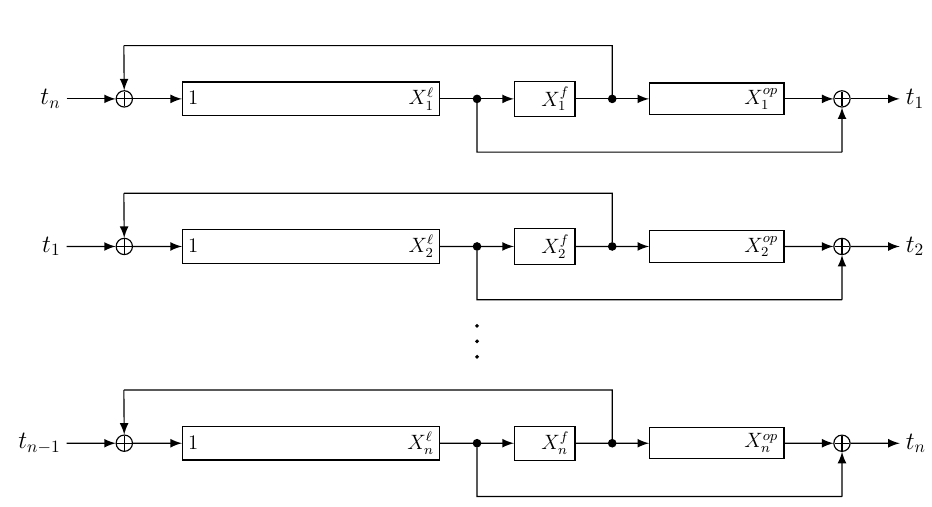
Figure 7: Generic Trivium ( X, n ) configuration of n chained